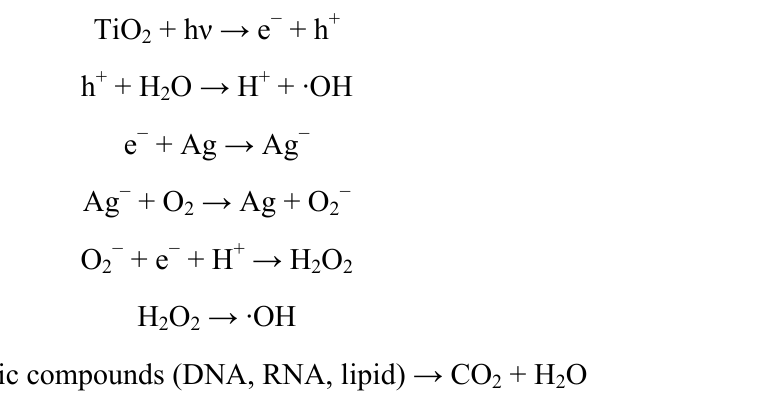
Table 1. Staph disinfection results of different Ag loading in Ag-TiO Ag Doping in TiO 2